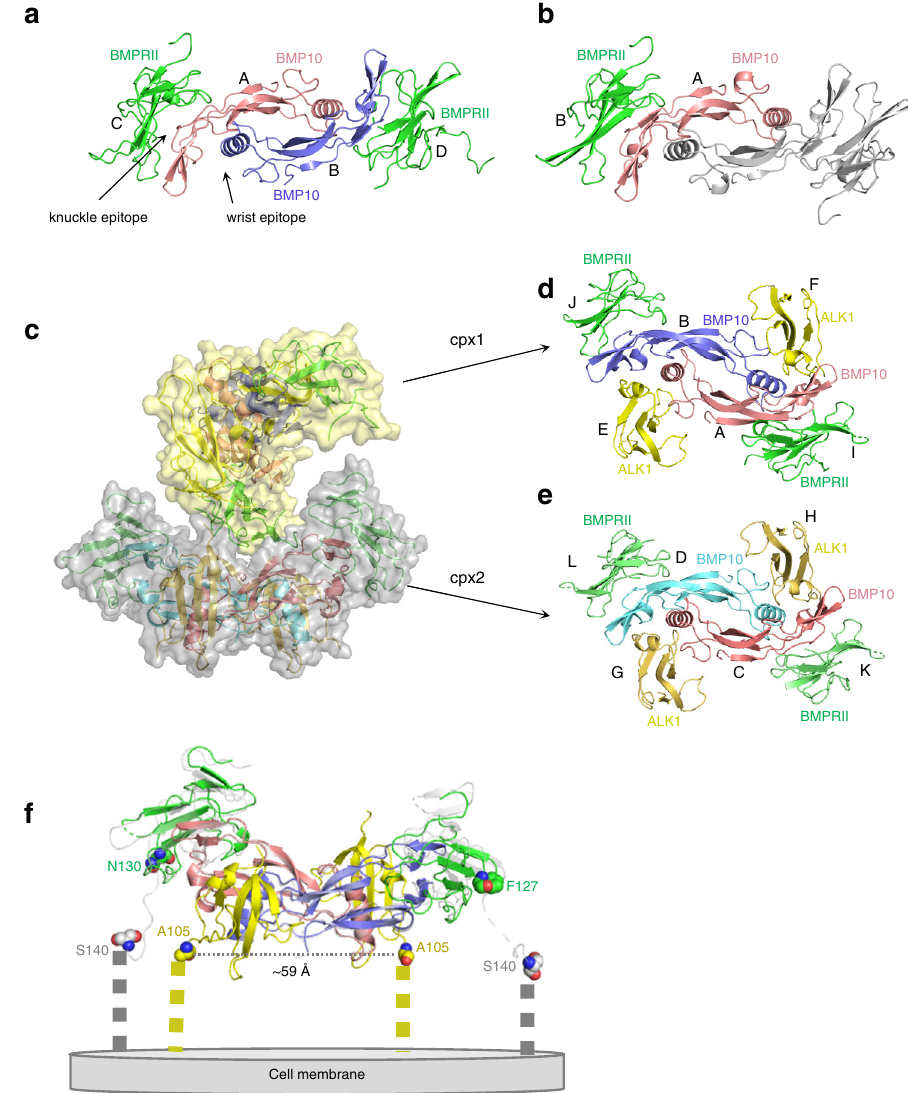
Fig. 1 Overall structures of BMP10:BMPRII and ALK1:BMP10:BMPRII complexes. a One asymmetric unit of the BMP10:BMPRII 1.48 Å crystal structure. Chain identities (IDs) A to D are labelled. BMP10 is coloured in coral and light purple, BMPRII coloured in green. b 2.4 Å structure of BMP10:BMPRII with chain IDs labelled. Only one monomer of BMP10 (in coral) and BMPRII (in green) in an asymmetric unit. One symmetry-related molecule is shown in grey to illustrate the BMP10 dimer bound to two copies of BMPRII. c – e Overall structure of the ALK1:BMP10:BMPRII complex. Four copies of each BMP10, ALK1 and BMPRII monomers are found in one asymmetric unit, forming two copies of ternary signalling complexes shown in semi-transparent yellow and grey surface. Chain IDs in complex 1 (cpx1) ( d ) and cpx2 ( e ) are shown. In cpx1, BMP10 monomers are coloured in coral and light purple, ALK1 in yellow